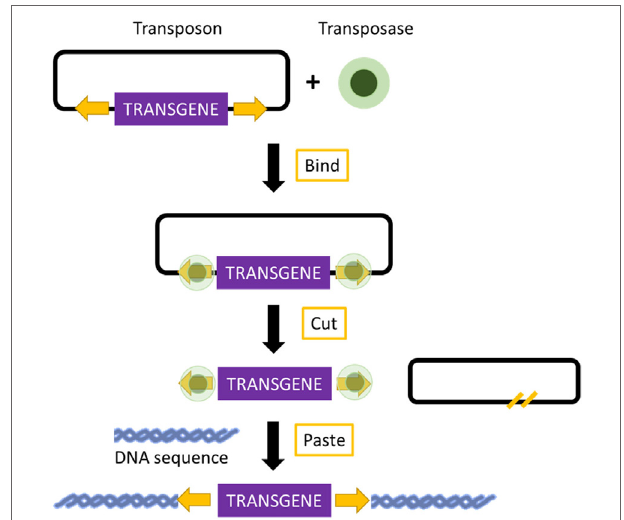
FiGURe 2 | Mechanism of transposon-based insertional mutagenesis. The transposon system is composed of a transposon (targeted sequence of DNA) and an enzyme (transposase). The transposase binds to the appropriate site along the transposon and excises the transposon. It then pastes the transposon at an appropriate location in another DNA sequence, TA site in the case of Sleeping Beauty, and a TTAA site in the case of